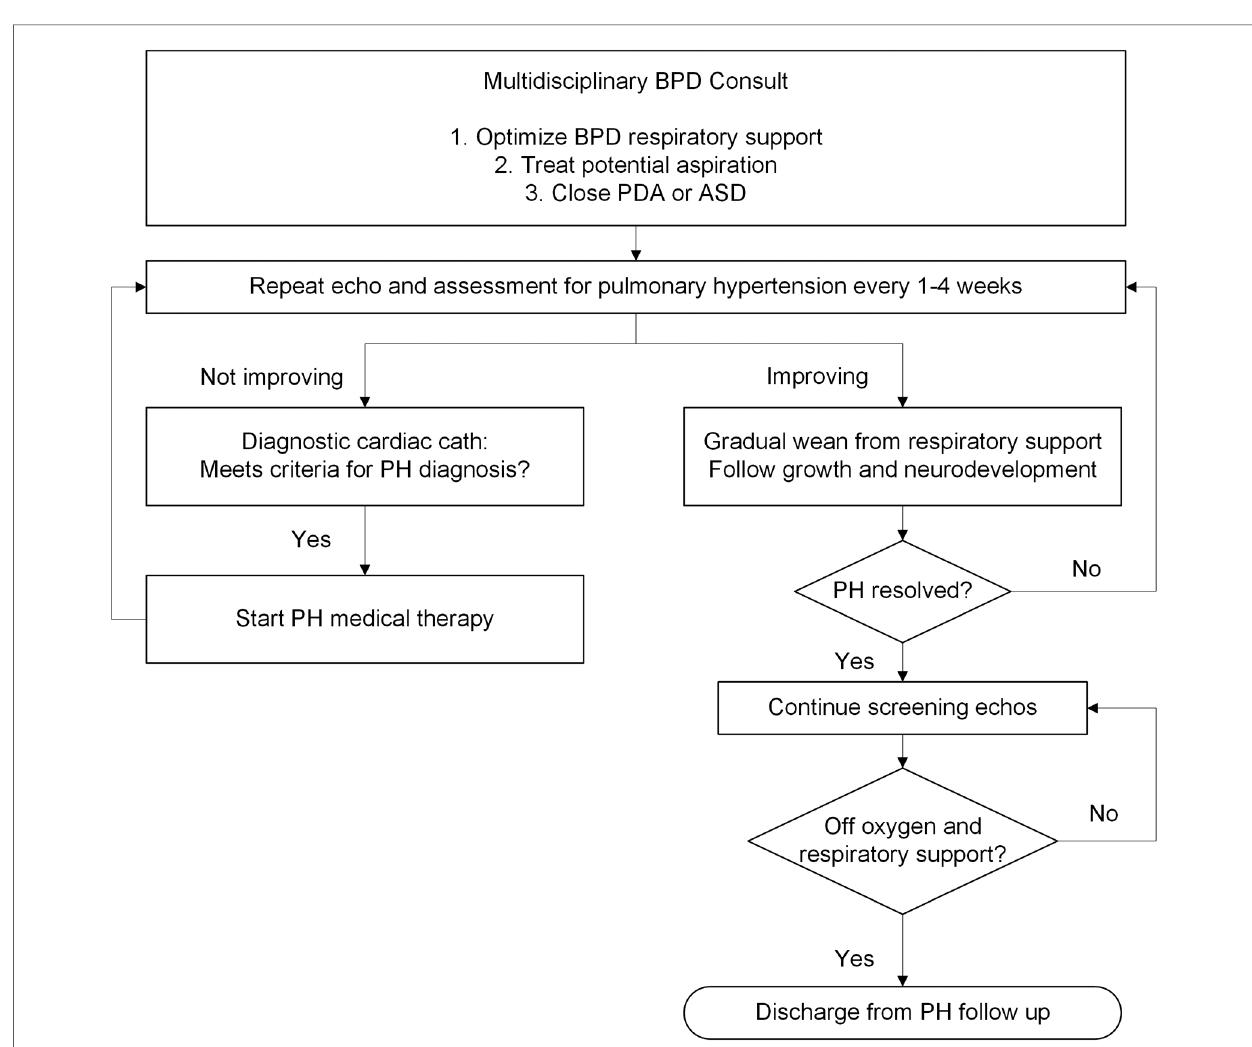
FIGURE 1 Algorithm of care for bronchopulmonary dysplasia-pulmonary hypertension (BPD-PH). PH, pulmonary hypertension; PDA, patent ductus arteriosus; ASD, atrial septal defect; Cath, catheterization; Echo,